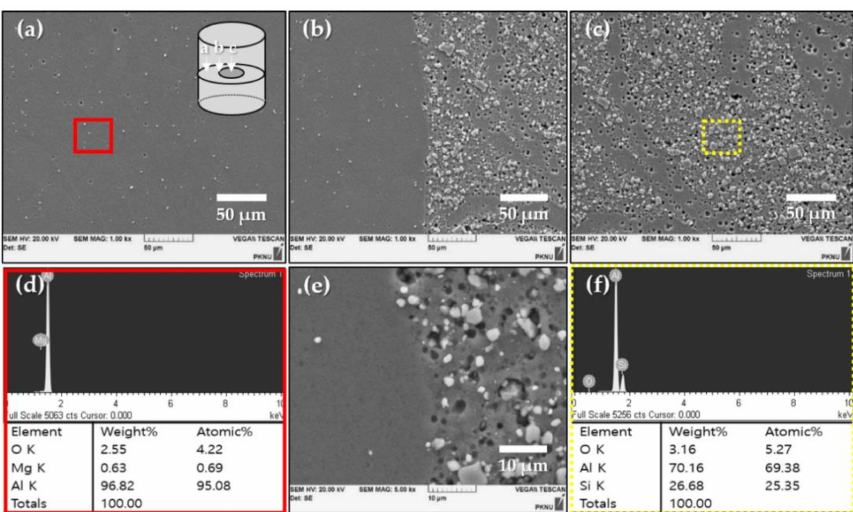
Figure 5. SEM images ( a – c , e ) and EDS results ( d , f ). ( a ) Region constituted by Al6063, ( b ) interface between Al6063 and Al3003, ( c ) region constituted by Al3003, ( d ) EDS of Al6063, ( e ) high-magnification image of the interfacial area between Al6063 and Al3003, and ( f ) EDS of Al3003.